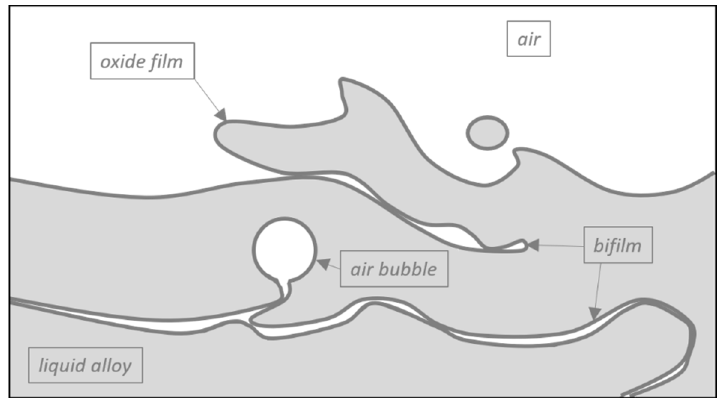
Figure 1. Scheme of bifilms and bubbles formation [8].